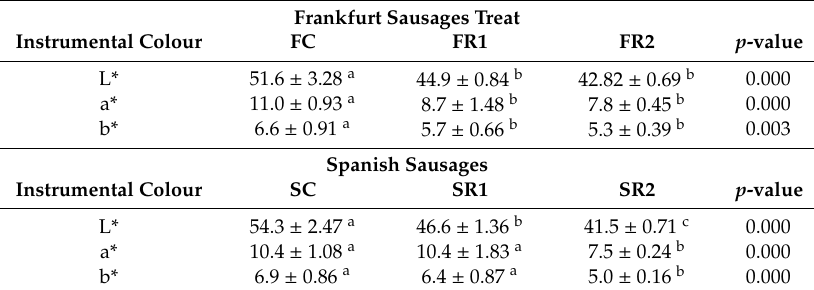
Table 3. Colour CIELAB means ± sd of Frankfurt and Spanish